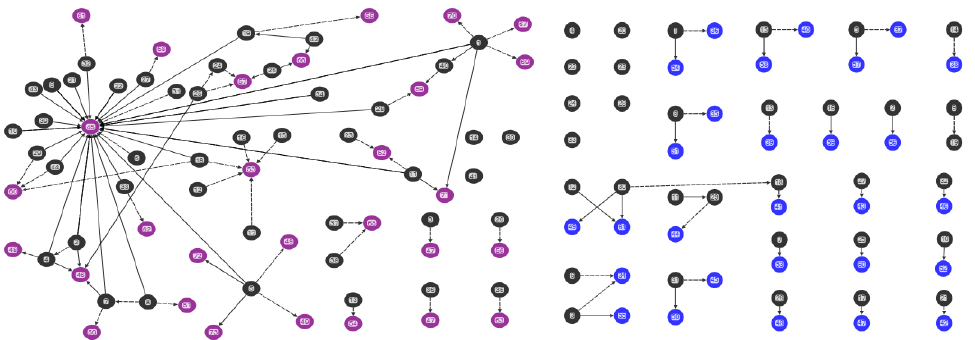
Figure 1. Combined mothers’ health advice-seeking network (Q15, Q23). “Rural 1” left hand side and “Urban 1” right side. Black nodes indicate mothers with children five years of age and younger, purple nodes indicate nominations, black ties denote health advice nominations and black dashed ties denote general advice nominations.